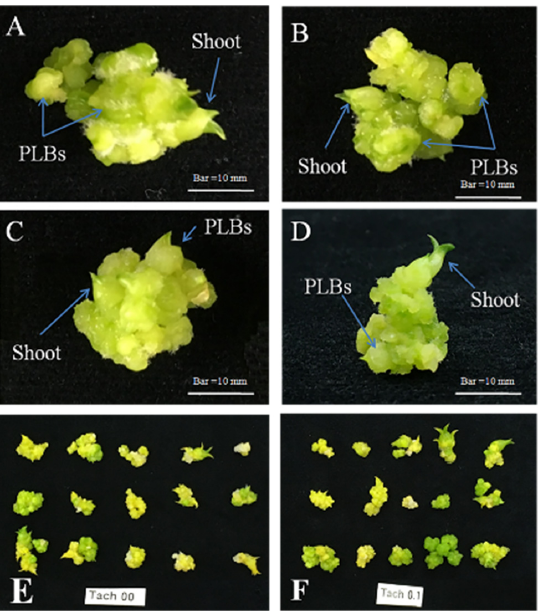
Figure 3. Formation of PLB and shoot of D. okinawense at different concentrations of HMI ( A – D ) from single PLB). ( A ) 0 ml/L (Control), ( B ) 0.01 ml/L, ( C ) 0.1 ml/L, ( D ) 1.0 ml/L of HMI, ( E ) newly generated PLBs in control from the fifteen mother PLBs, ( F ) newly generated PLBs in 0.1 ml/L from the fifteen mother PLBs.